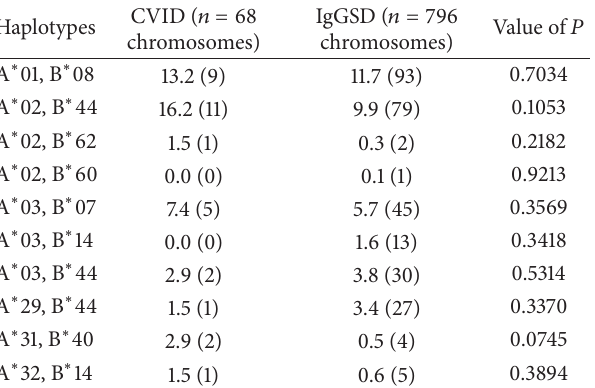
Table 6: Positivity for HLA-B types in 432 adult CVID/IgGSD index patients 1 .